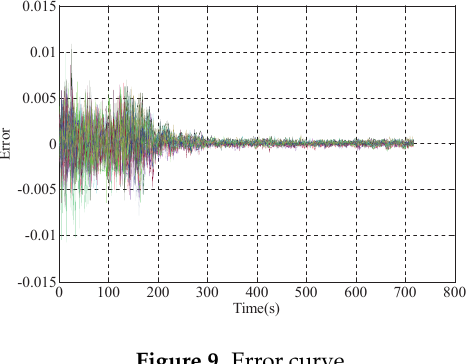
Figure 9. Error curve.